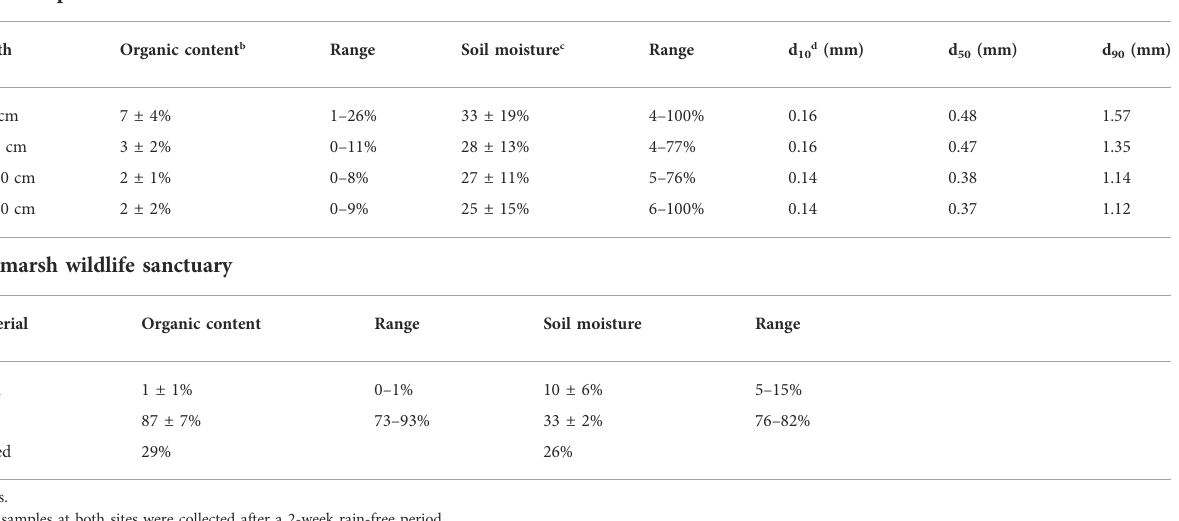
TABLE 1 Summary of pre-restoration soil organic content, soil moisture and grain size. Foothills